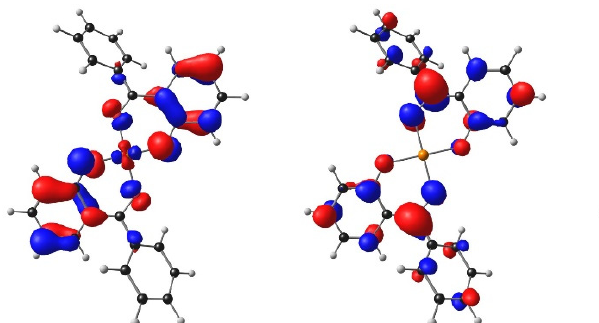
lected MOs are visualized. A contour of 0.06 e/Å 3 was used for the orbital plot. Colour code of atoms (online version): Cu (orange), C (grey), O (red), H (white).